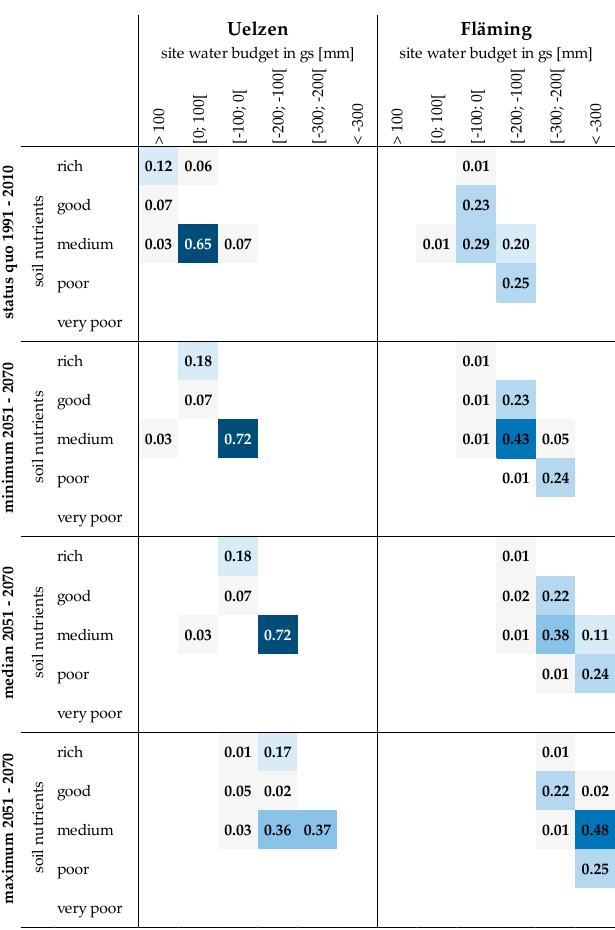
Figure 3. Proportion of sites according to soil nutrient classes and site water budget in growing season classes in Uelzen and Fläming (top heatmaps for the period 1991 to 2010; three rows of heatmaps below for site water budget conditions in the period 2051 to 2070 under three climate scenarios of minimum, median and maximum; only classes with proportions greater than 1% are listed).